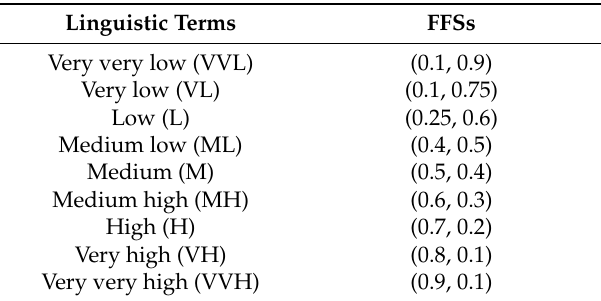
Table 3. The linguistic terms and FFSs.